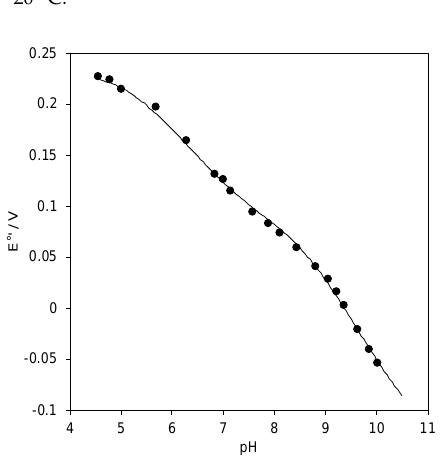
Figure 7. pH dependence of E°’ for Streptomyces coelicolor small laccase (SLAC) covalently bound to 1:1 MUA/MU gold electrode through EDC/NHS linkage procedure. 5 mM Tris-HCl buffer plus 5 mM sodium perchlorate, T = 20 °C. The error bars are not shown because they have the same dimension of the symbols.